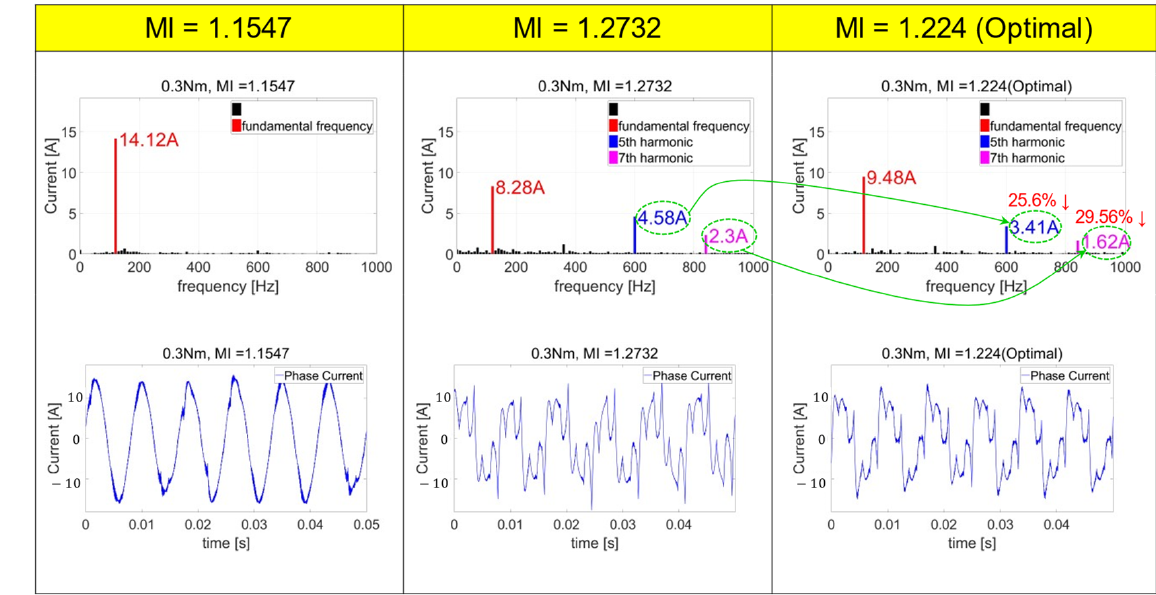
Figure 20. Comparison results of phase current ripple of optimal MI and fixed MI. When MI was controlled to 1.1547, the phase current was close to a sine wave. Even in the FFT analysis result, there was no noticeable ripple component and there was only a small amount of high-frequency